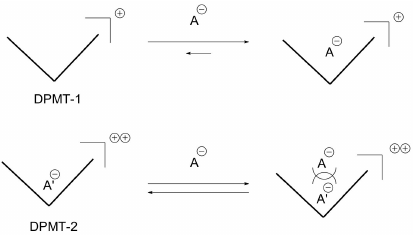
Figure 3. Simplified binding